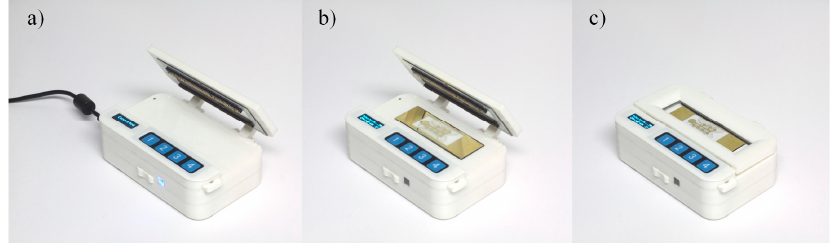
Figure 10. Device implementation ( a ) Charging / PC connected; ( b ) Open; ( c ) Closed.